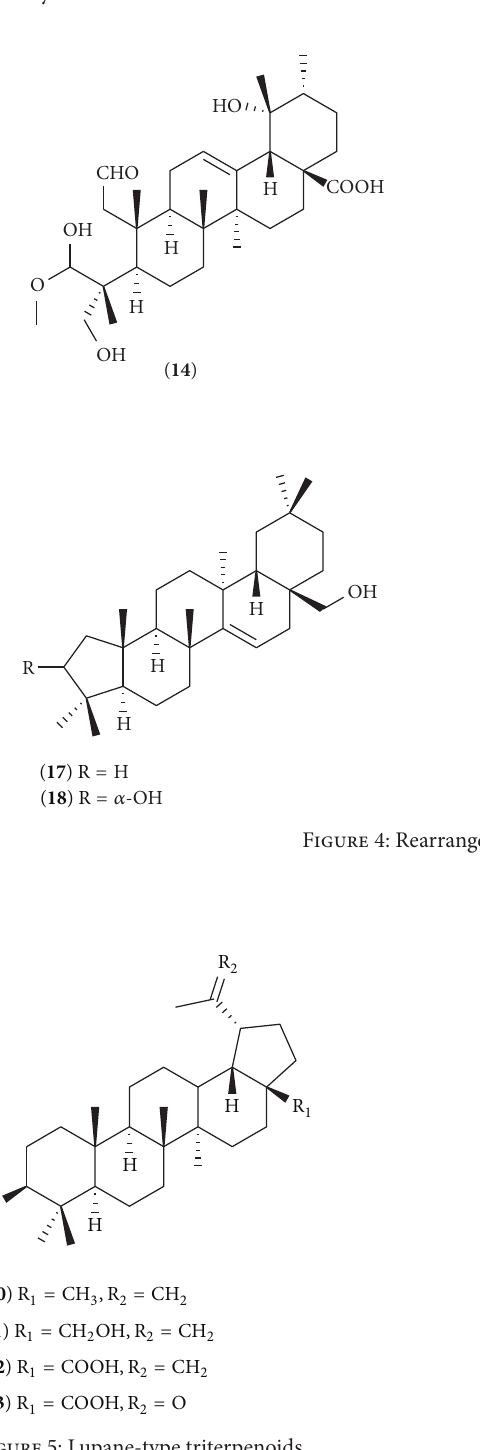
Figure 5: Lupane-type